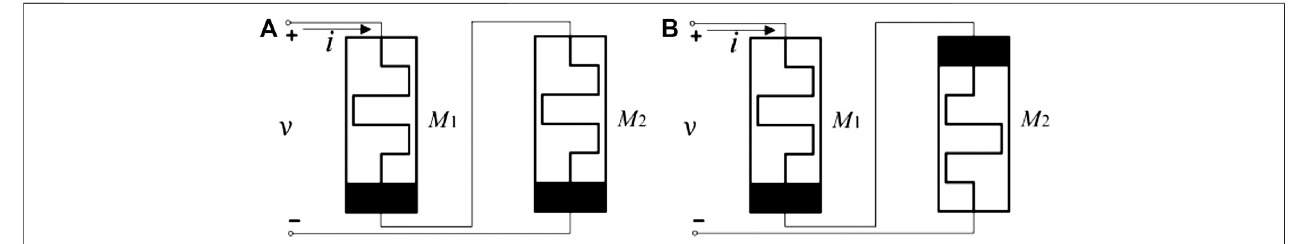
FIGURE 9 | Two serial memristor circuits with (A) same polarities, and (B) opposite polarities.